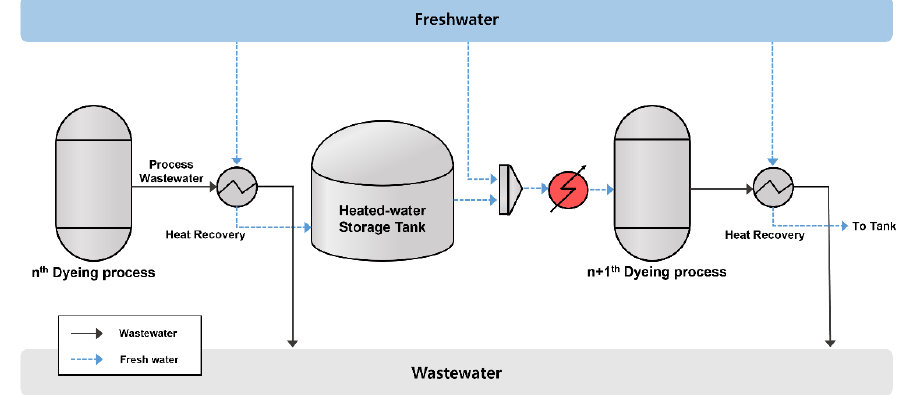
Figure 2. Schematic of the waste heat recovery system in the dyeing process. Table 1. Process conditions of the dyeing process.